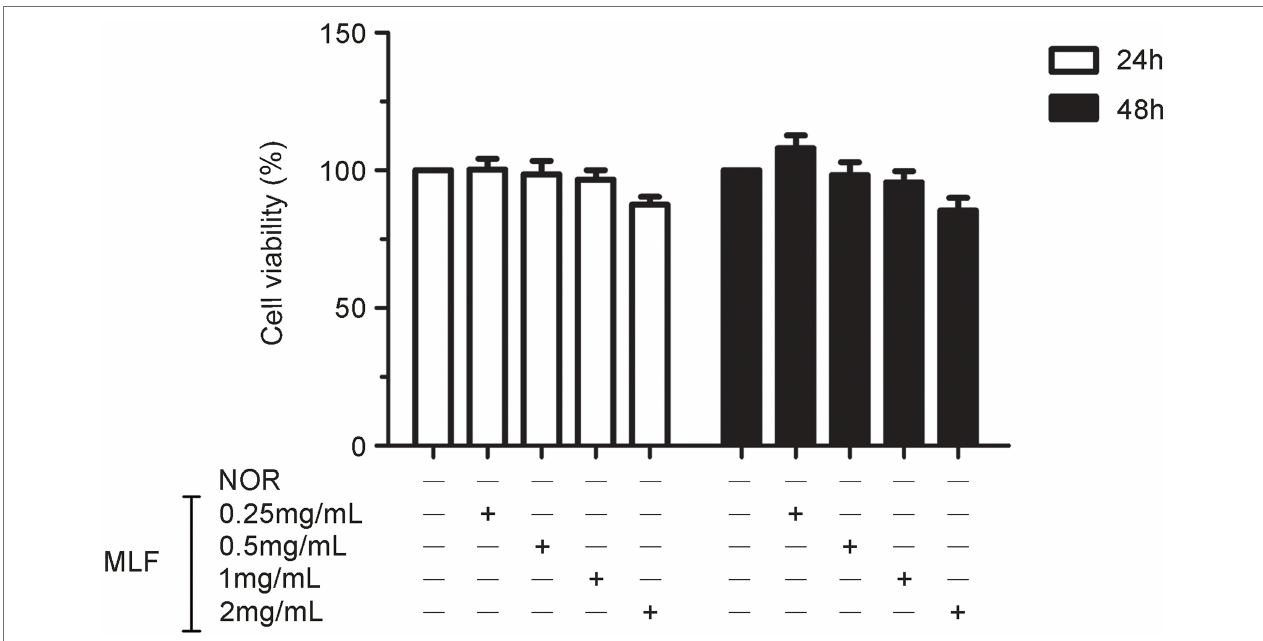
FIGURE 1 | Effects of metabolites of Lactobacillus fermentum F-B9-1 (MLF) on the cell viability of Caco-2 cells detected by 3-(4,5-dimethylthiazolyl-2)-2,5- diphenyltetrazolium bromide (MTT). Caco-2 cells were treated with different concentrations (0.25, 0.5, 1, and 2 mg/ml) of MLF for 24 and 48 h. The OD were examined in Caco-2 cells which were pretreated with 5 mg/ml MTT for 4 h, then treated with dimethylsulfoxide (DMSO).